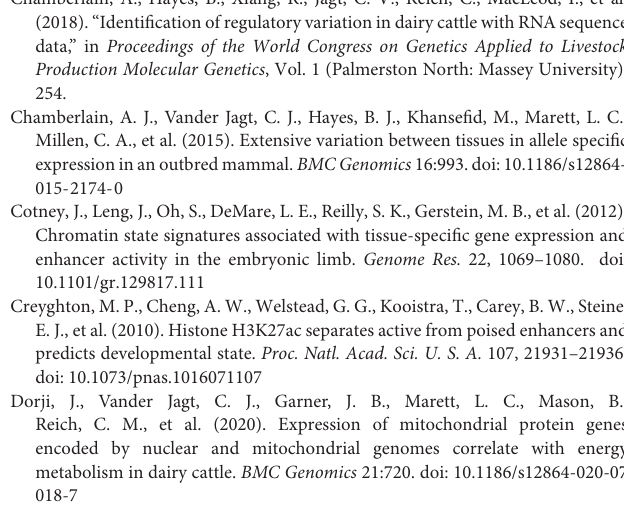
Supplementary Table 5 | Enrichment of 7 Chromatin states in different tissues at annotated regions of the bovine genome. Where state1 is “inactive promoter,” state 2 is “repressed,” state 3 is “no signal,” state 4 is “hyperChIPable regions,” state 5 is “active enhancer,” state 6 is “permissive,” and state 7 is “active promoter.” Darker green indicates higher enrichment. Supplementary Table 6 | Enrichment of SNP datasets within peaks. The enrichment of each SNP dataset within peaks for each sample. Significance of enrichment or depletion was determined with a hypergeometric test. A summary table is included to the right with average enrichment for each tissue. Darker green indicates higher enrichment. Supplementary Table 7 | Enrichment of SNP datasets within differentially bound peaks. The enrichment of each SNP dataset within differentially bound peaks for each sample with either higher (Up) or lower (Down) binding. Significance of enrichment or depletion was determined with a hypergeometric test. A summary table is included to the right with average enrichment for each tissue. Darker green indicates higher enrichment. Supplementary Table 8 | Number of peaks correlated with gene expression. Number of peaks for each mark whose height correlated with gene expression. Supplementary Table 9 | Enrichment of putative causal variants of peaks and peaks correlated with gene expression. Enrichment of each SNP dataset within peaks and peaks correlated with gene expression. Filtering for correlation with gene expression increased enrichment for causal variants. Enrichment was significant with P < 0.001 for all tests. Supplementary Table 10 | Enrichment of SNP datasets within ChromHMM states. The enrichment of each SNP dataset within each state in each tissue. Significance of enrichment or depletion was determined with a hypergeometric test. A summary table is included to the right with average enrichment for each tissue. Supplementary Table 11 | The number of SNPs in each dataset grouped by distance to nearest transcription start site. For each SNP dataset we grouped SNPs based on distance to nearest transcription start site in bins of 100 kb. Supplementary Table 12 | The number of peaks grouped by distance to transcription start site, averaged over samples. The average number of peaks, grouped by distance to the nearest transcription start site, tested for